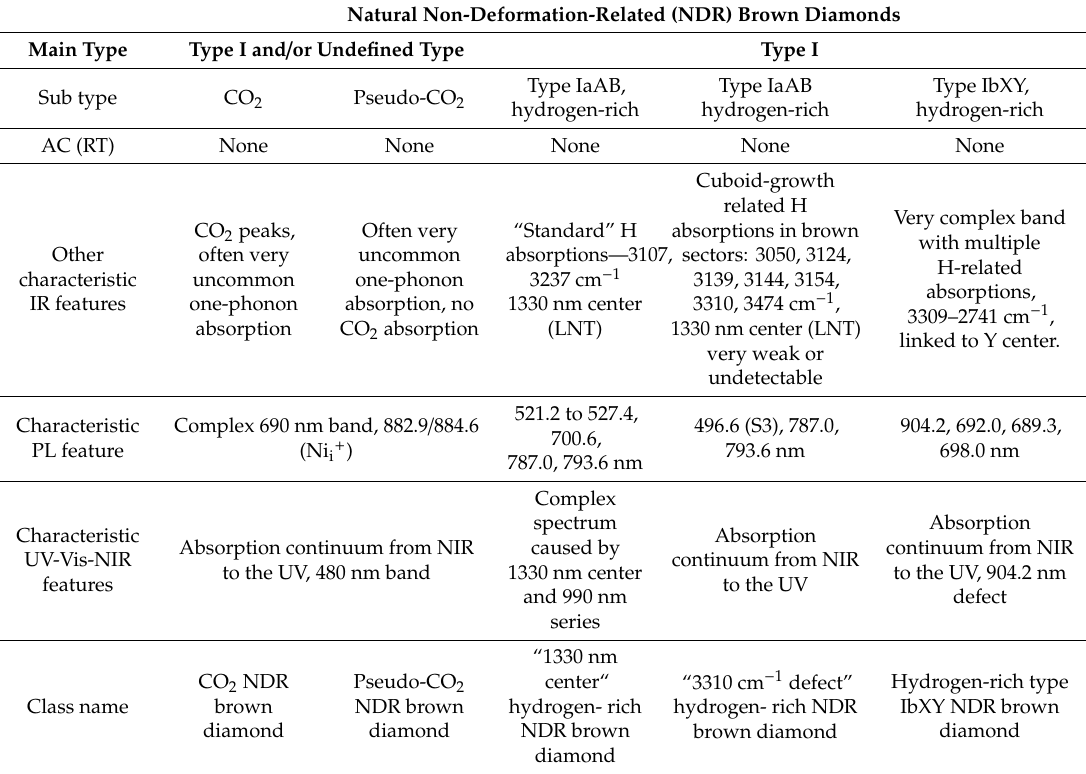
Table 2. The newly elaborated classification of natural untreated NDR brown